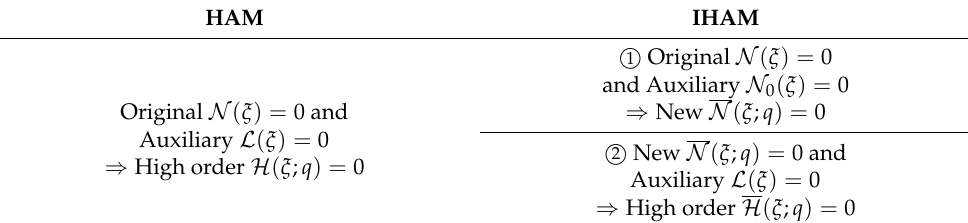
Table 1. Improved homotopy analysis method vs. homotopy analysis